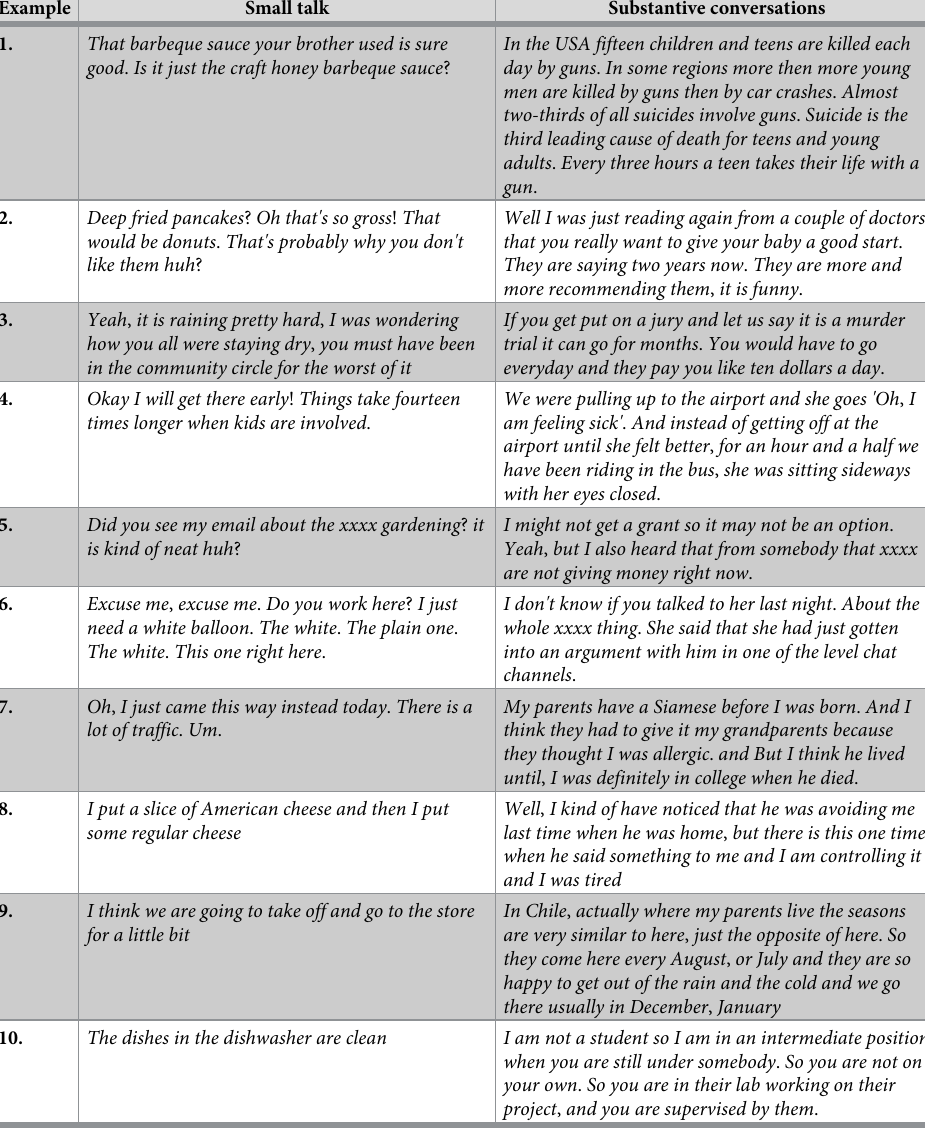
Table 1. Examples of small talk and substantive